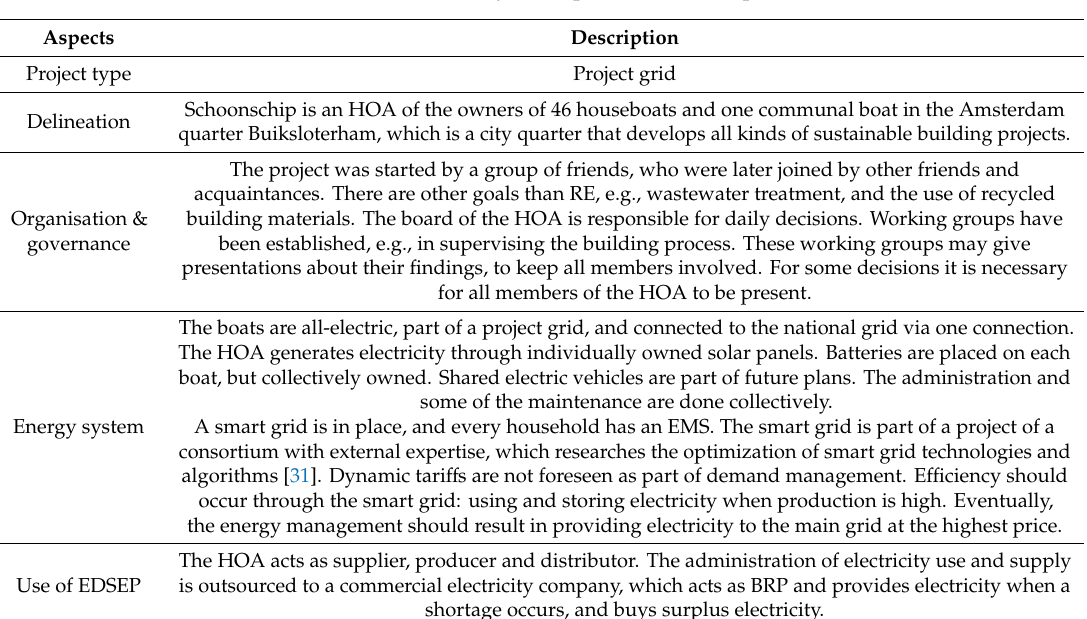
Table 6. Case study description